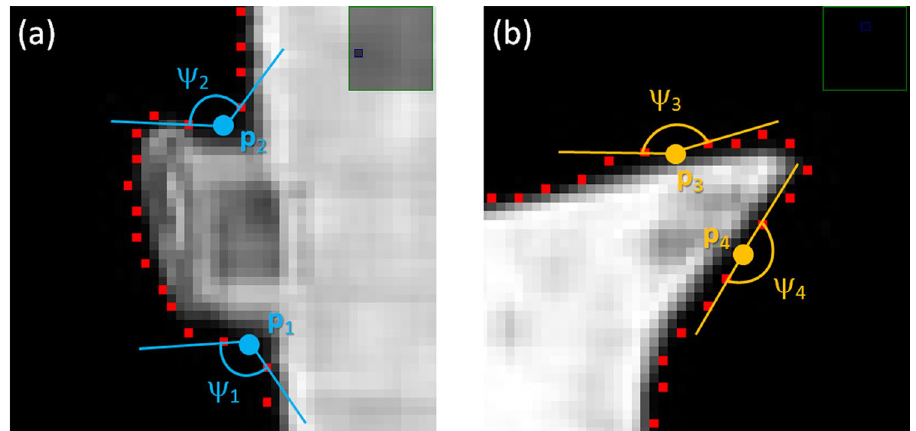
Figure 4. Some examples of bottleneck detection. The exterior angles of the potential points p 1 , p 2 , p 3 , p 4 are 110°, 120°, 161°, and 180°, respectively. The cost function in both ( a ) and ( b ), computed by Eq. (9) were